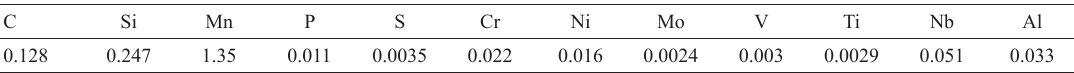
Table 1: Chemical composition (wt. %) of API 5L X65 analyzed steel.